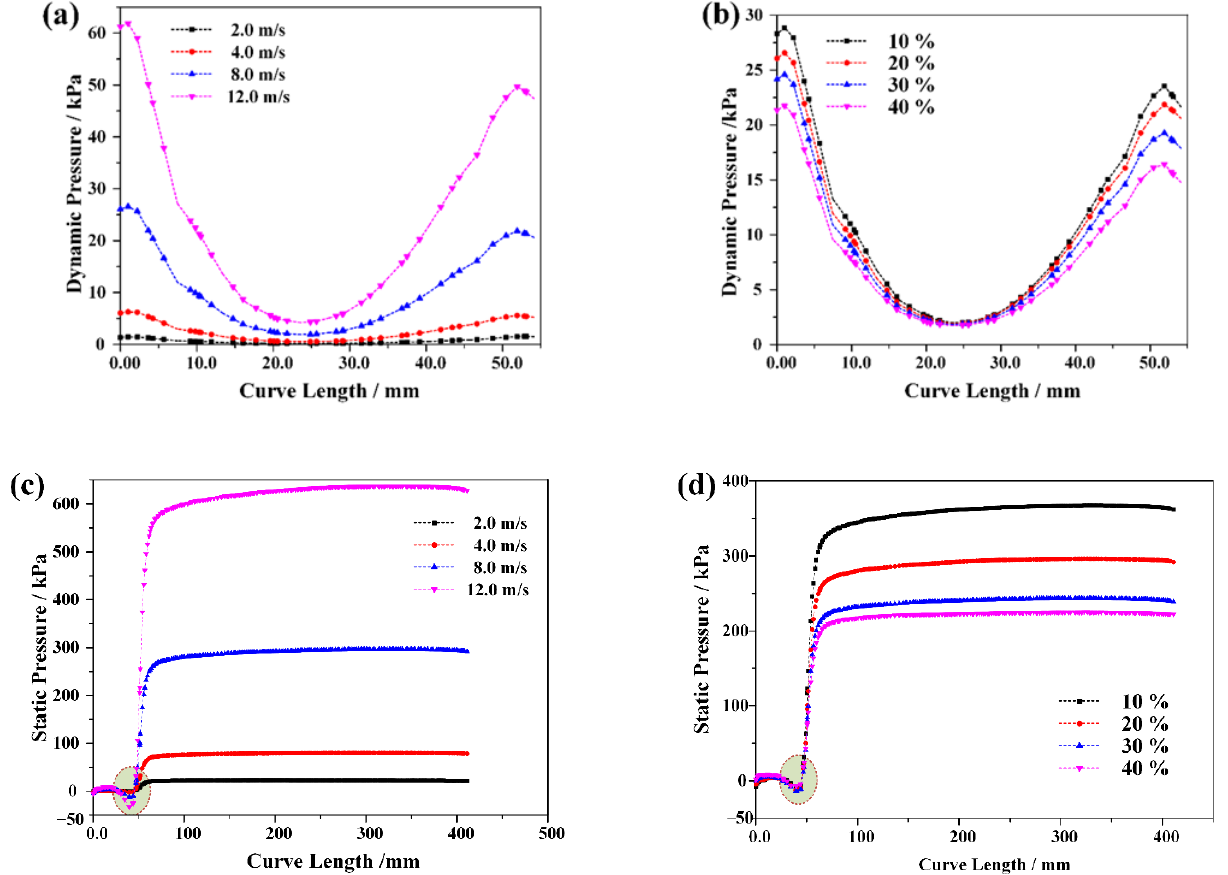
Figure 6. The partial pressure of tar vapor in radial and axial direction of cyclone. ( a ) Radial pressure with water content of 20%, ( b ) radial pressure when inlet velocity is 8.0 m/s, ( c ) axial pressure with water content of 20%, and ( d ) axial pressure when inlet velocity is 8.0 m/s.